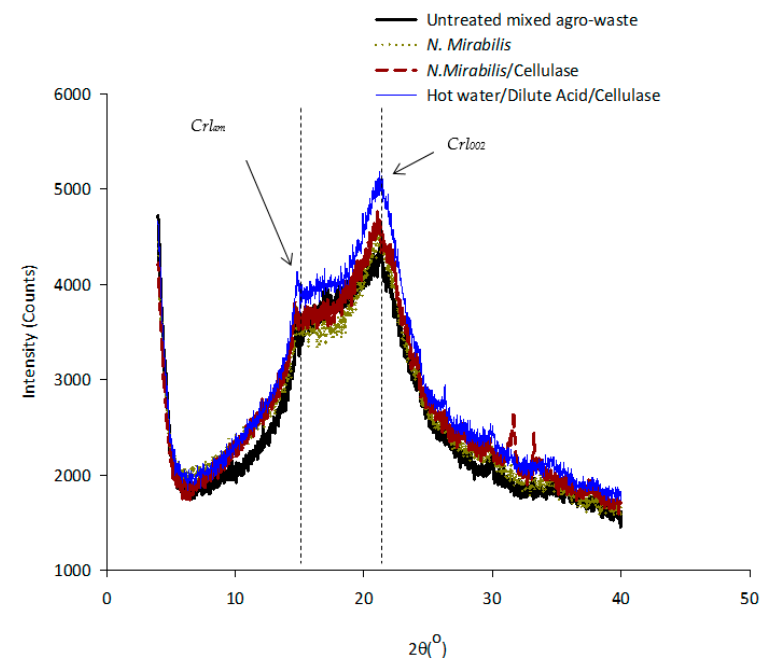
Figure 2. X-ray diffraction spectrum for un- and hydrolysed mixed agro-waste. Figure 1. X-ray diffraction spectrum for un- and hydrolysed mixed agro-waste. Table 7. Crystallinity index values of pooled hydrolysed mixed agro-waste samples after 168 h. Hydrolysis